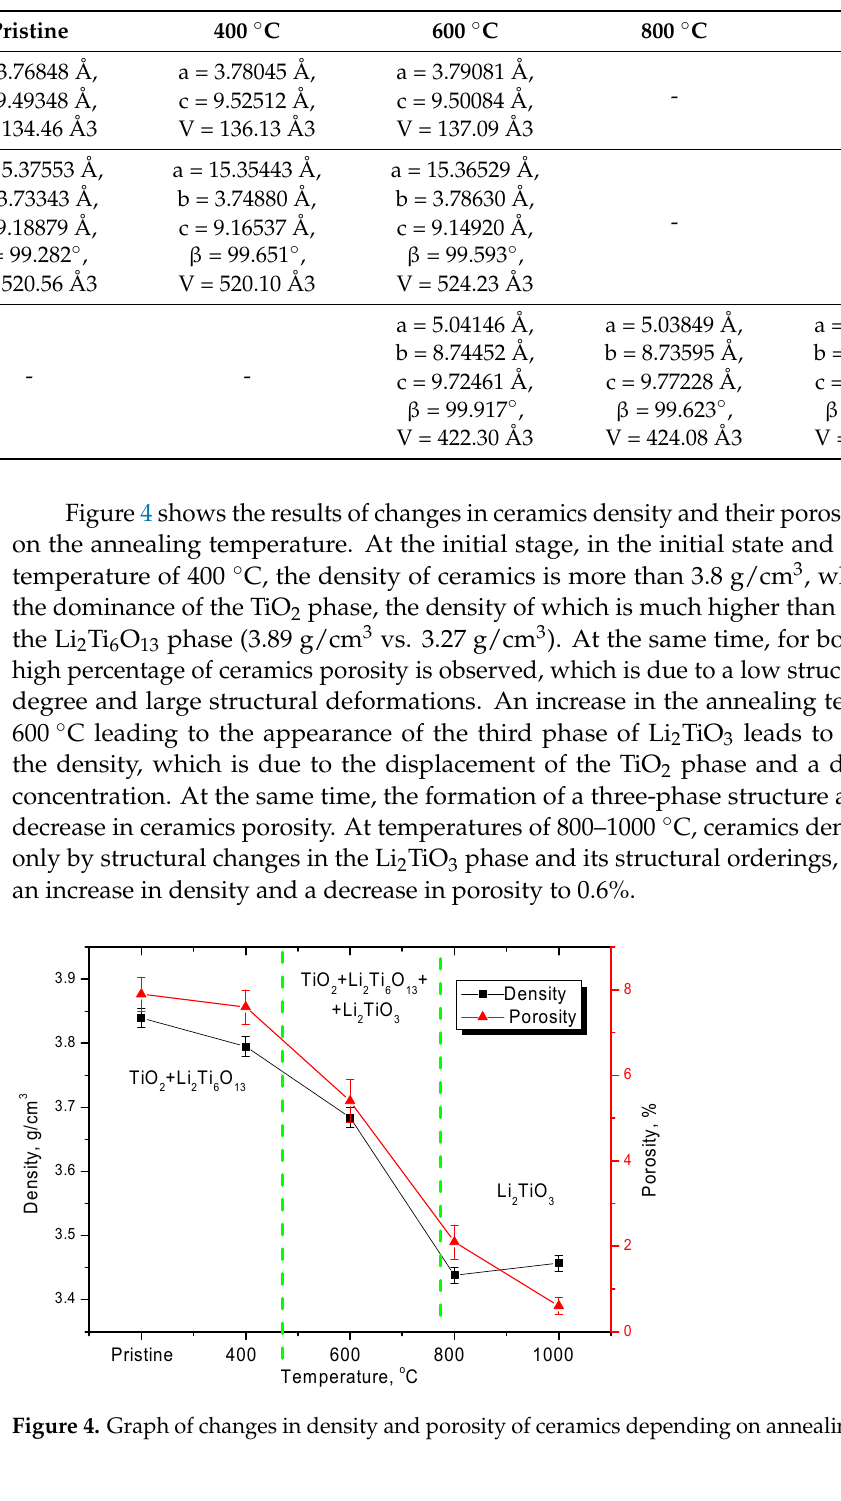
Table 1. Crystallographic characteristics of the studied ceramics.